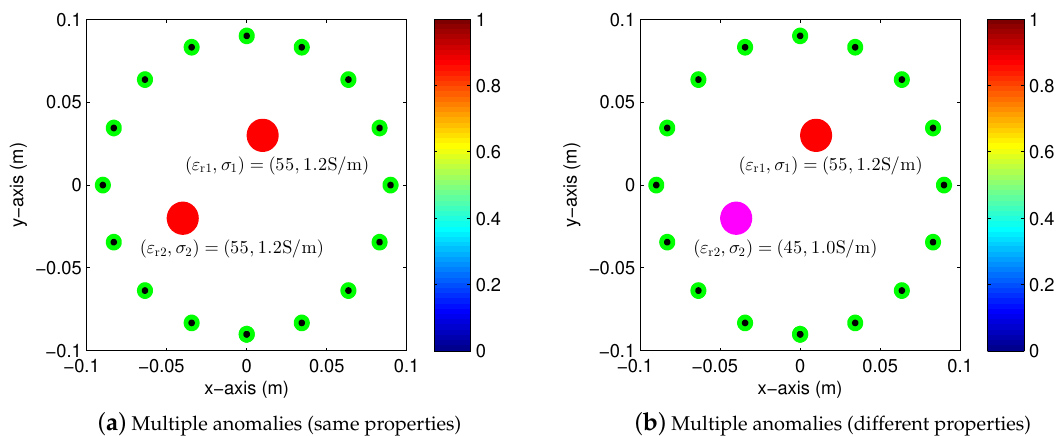
Figure 4. Illustration of simulation configuration for multiple